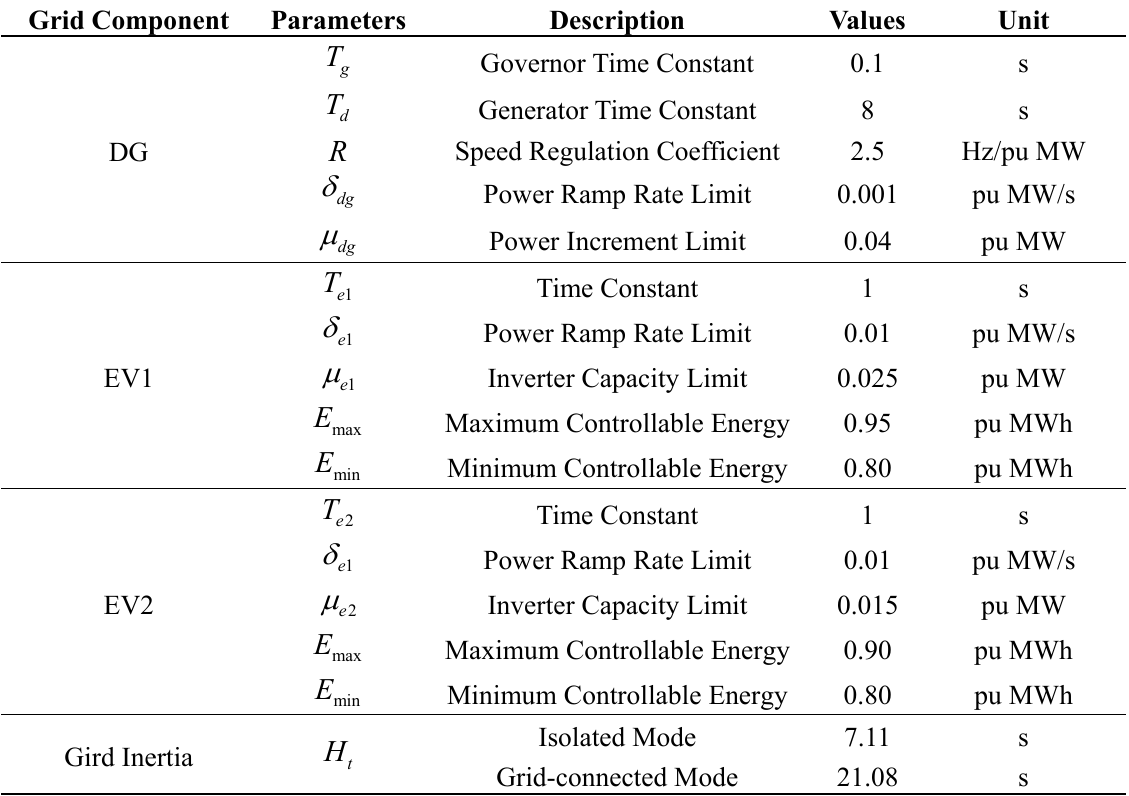
Table A1. System parameters.